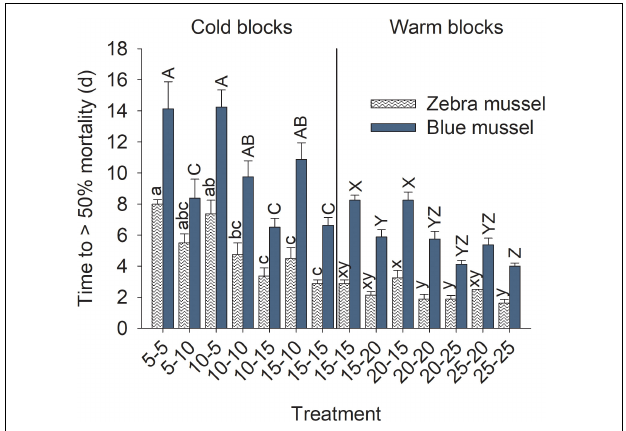
FIGURE 7 | Time to > 50% mortality of marine blue mussels ( Mytilus edulis ) and freshwater zebra mussels ( Dreissena polymorpha ) during the exposure phase of the experiment. Bars show mean (+SE, n = 4) and columns not sharing a common letter (within a Block and Species combination) are significantly different (Tukey post hoc tests). Vertical lines show the separation between the cold and warm blocks; capital letters are for blue mussels and lowercase for zebra